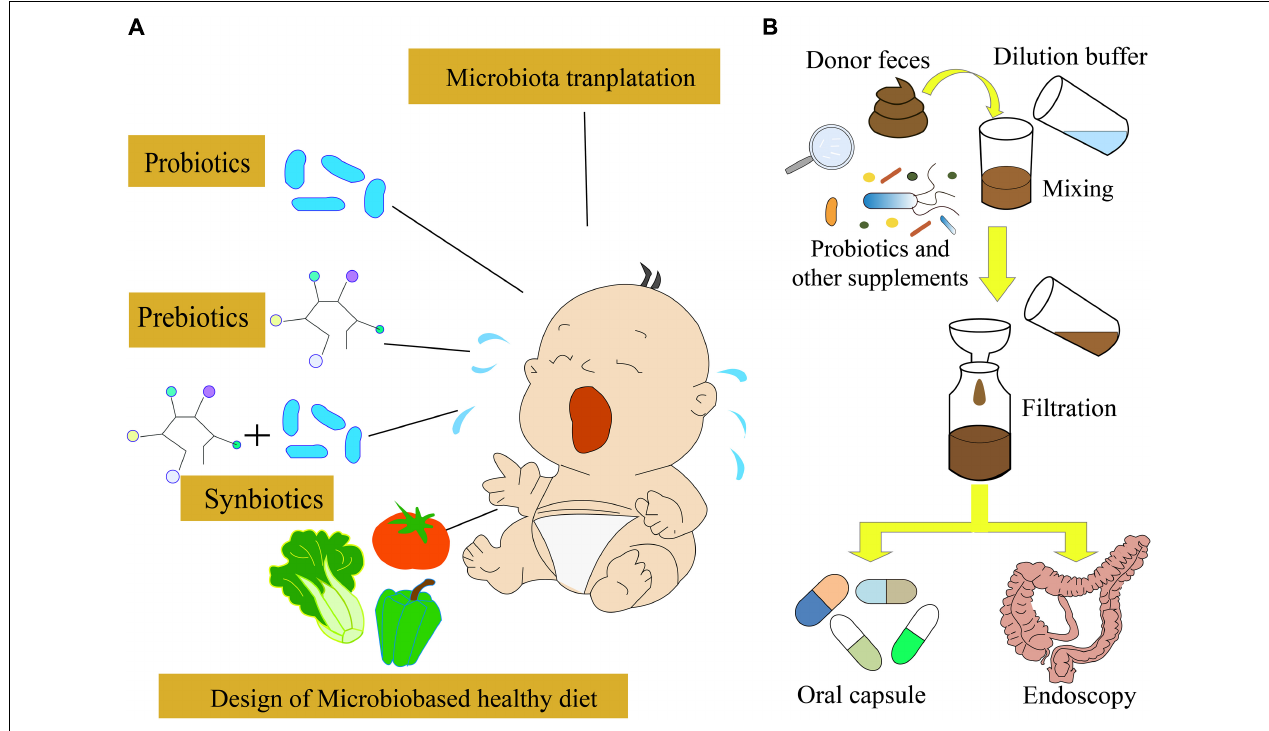
FIGURE 2 | Different strategies for CMPA treatment. (A) Probiotics, prebiotics, and synbiotics are often used for CMPA treatment. In the future, the microbiota-targeted design of a healthy diet might be possible to treat CMPA infants. (B) Fecal microbiota transplantation strategy used for CMPA treatment.